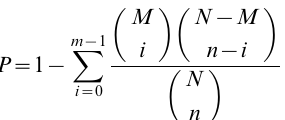
arrows indicate a possible relationship; perpendicular lines indicate a repressive effect. Genes are shown in rectangles and proteins are shown in circles. Vernalization pathway genes are shown in blue, autonomous pathway genes in pink, photoperiod pathway genes in green, and GA-signaling pathway genes in purple. Floral pathway integrators are shown in red, and floral meristem identity genes are shown in grey. Labels: v indicates vernalization; ld indicates long days; sd indicates short days. Bold and italicized typeface indicates genes and proteins for which similar unigenes were found in D. latiflorus in the present study. * indicates the gene was first identified in maize but lacks homologs in Arabidopsis. Table S1 Top BLAST hits from public databases. A list of the top results from BLASTING D. latiflorus unigenes against public databases (E-value cutoff of 10 2 5 ). Table S2 List of unigenes showing differential tran- script abundance. A list of the unigenes showing differential transcript abundance in flowers of phase 1 and phase 2. Table S3 Enriched plant-specific GO terms for uni- genes showing differential transcript abundance. A list of the plant-specific GO terms enriched for unigenes showing higher transcript abundance in phase 1 and phase 2, respectively (p , 0.05). Table S4 Enriched KEGG pathways for unigenes show- ing differential transcript abundance. A list of KEGG pathways enriched for unigenes showing higher transcript abundance in phase 1 and phase 2, respectively (p , 0.05). Table S5 Representatives of putative flowering-time genes in D.latiflorus . A list of the D. latiflorus putative flowering time control genes and their possible functions. Table S6 Putative flower development genes in D. latiflorus . A list of the genes putatively related to flower development in D. latiflorus and their possible